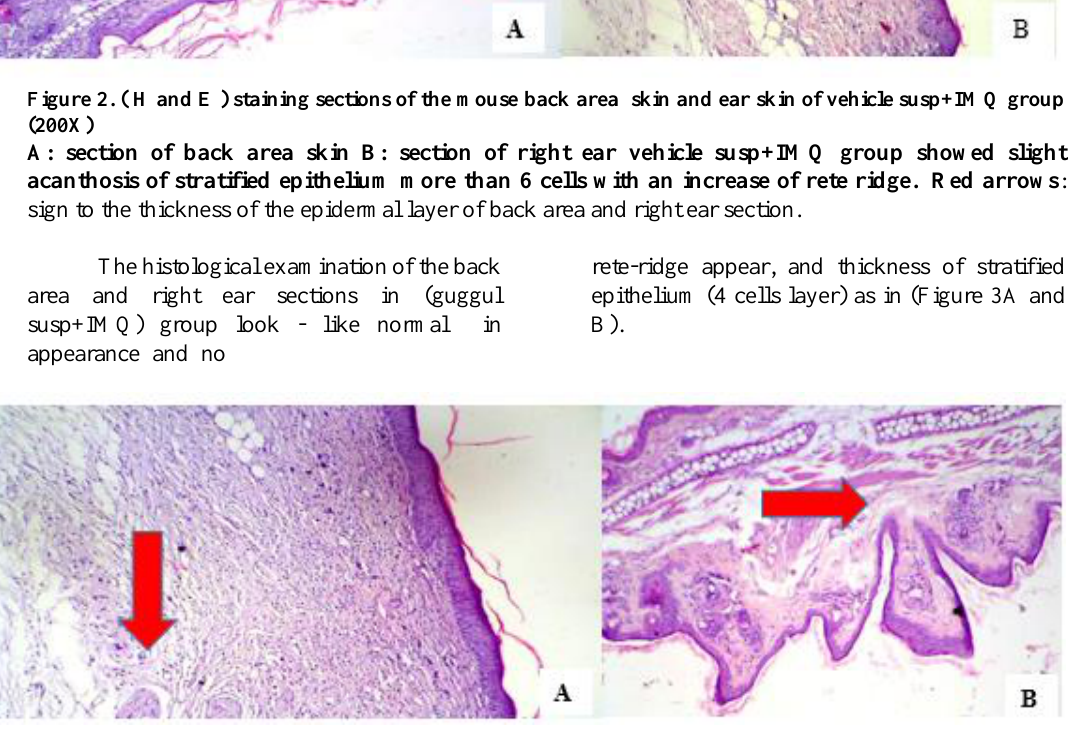
Figure 3. (H and E) staining sections of the mouse back area skin and ear skin of (IMQ+ guggul oint) group (200X) . A: Section of right ear B: Section of the back area. Red arrows : sign to the thickness of the epidermal layer of back area and right ear section